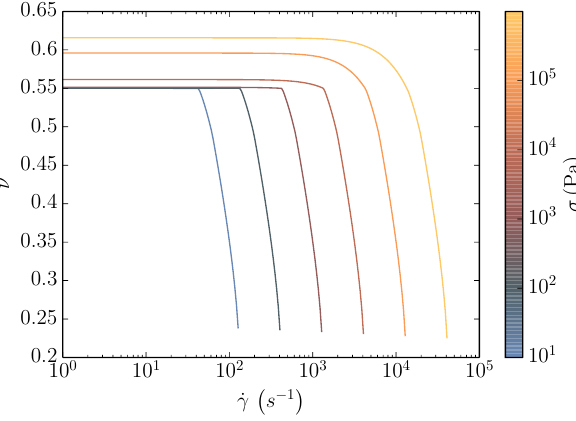
Figure 5. Concentration ν in dependence of normal stress σ and shear rate ˙ γ .